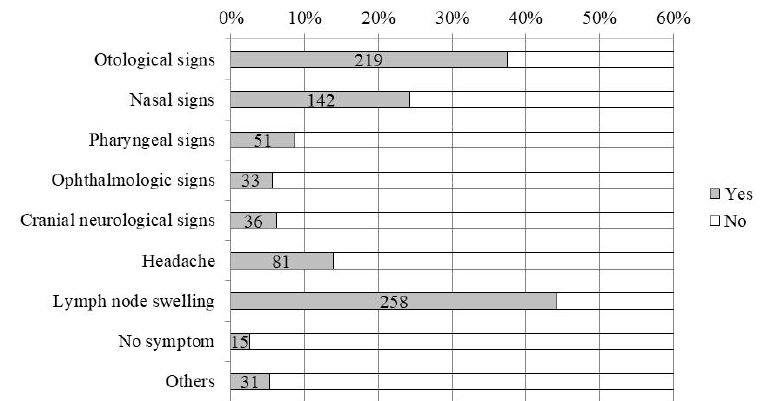
Figure 3. Clinical symptoms. The proportion of each symptom is shown on the horizontal axis. The maximum value on the horizontal axis was adjusted to 60%. Gray boxes indicate patients with symptoms, and the numbers indicate the number of cases.